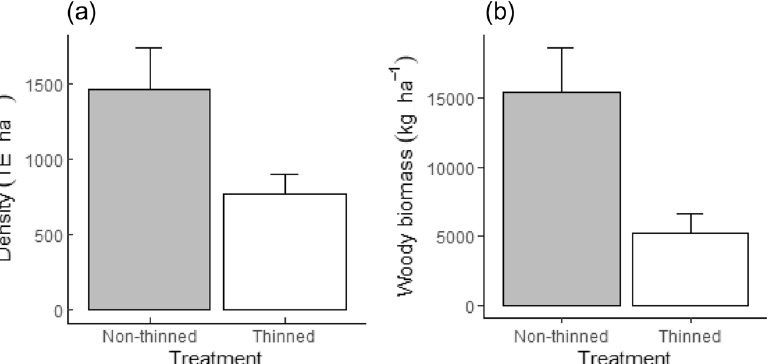
Figure 3. Expected ( a ) densities (TE ha −1 ), and ( b ) dry wood biomass (kg ha −1 ) of encroaching trees/shrubs in the thinned and non-thinned treatment areas estimated from the linear mixed-effects (LME) model coefficients. Error bars indicate ± 95% confidence level of the variability in tree/shrub densities (TE ha −1 ) and woody biomass (kg ha −1 ) of the non-thinned and thinned areas.